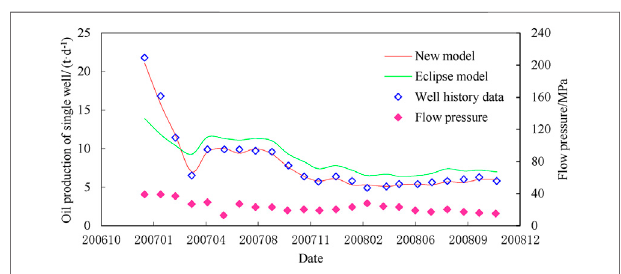
FIGURE12| TheoilproductioncomparisonresultsofthewellW587-X3.